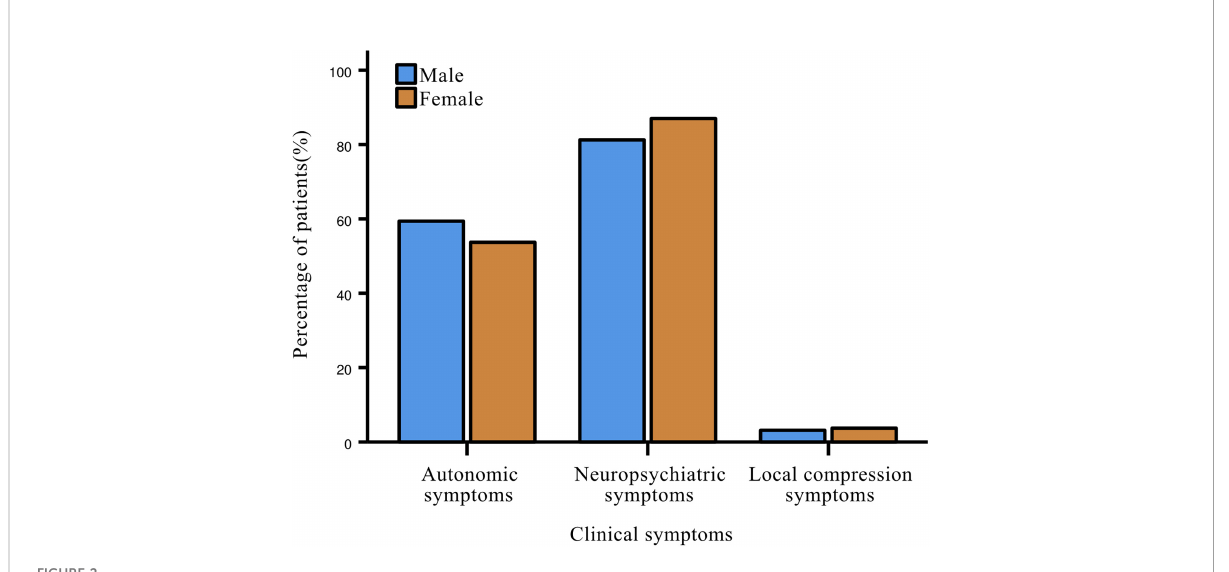
FIGURE 2 Gender differences in clinical symptoms of patients with